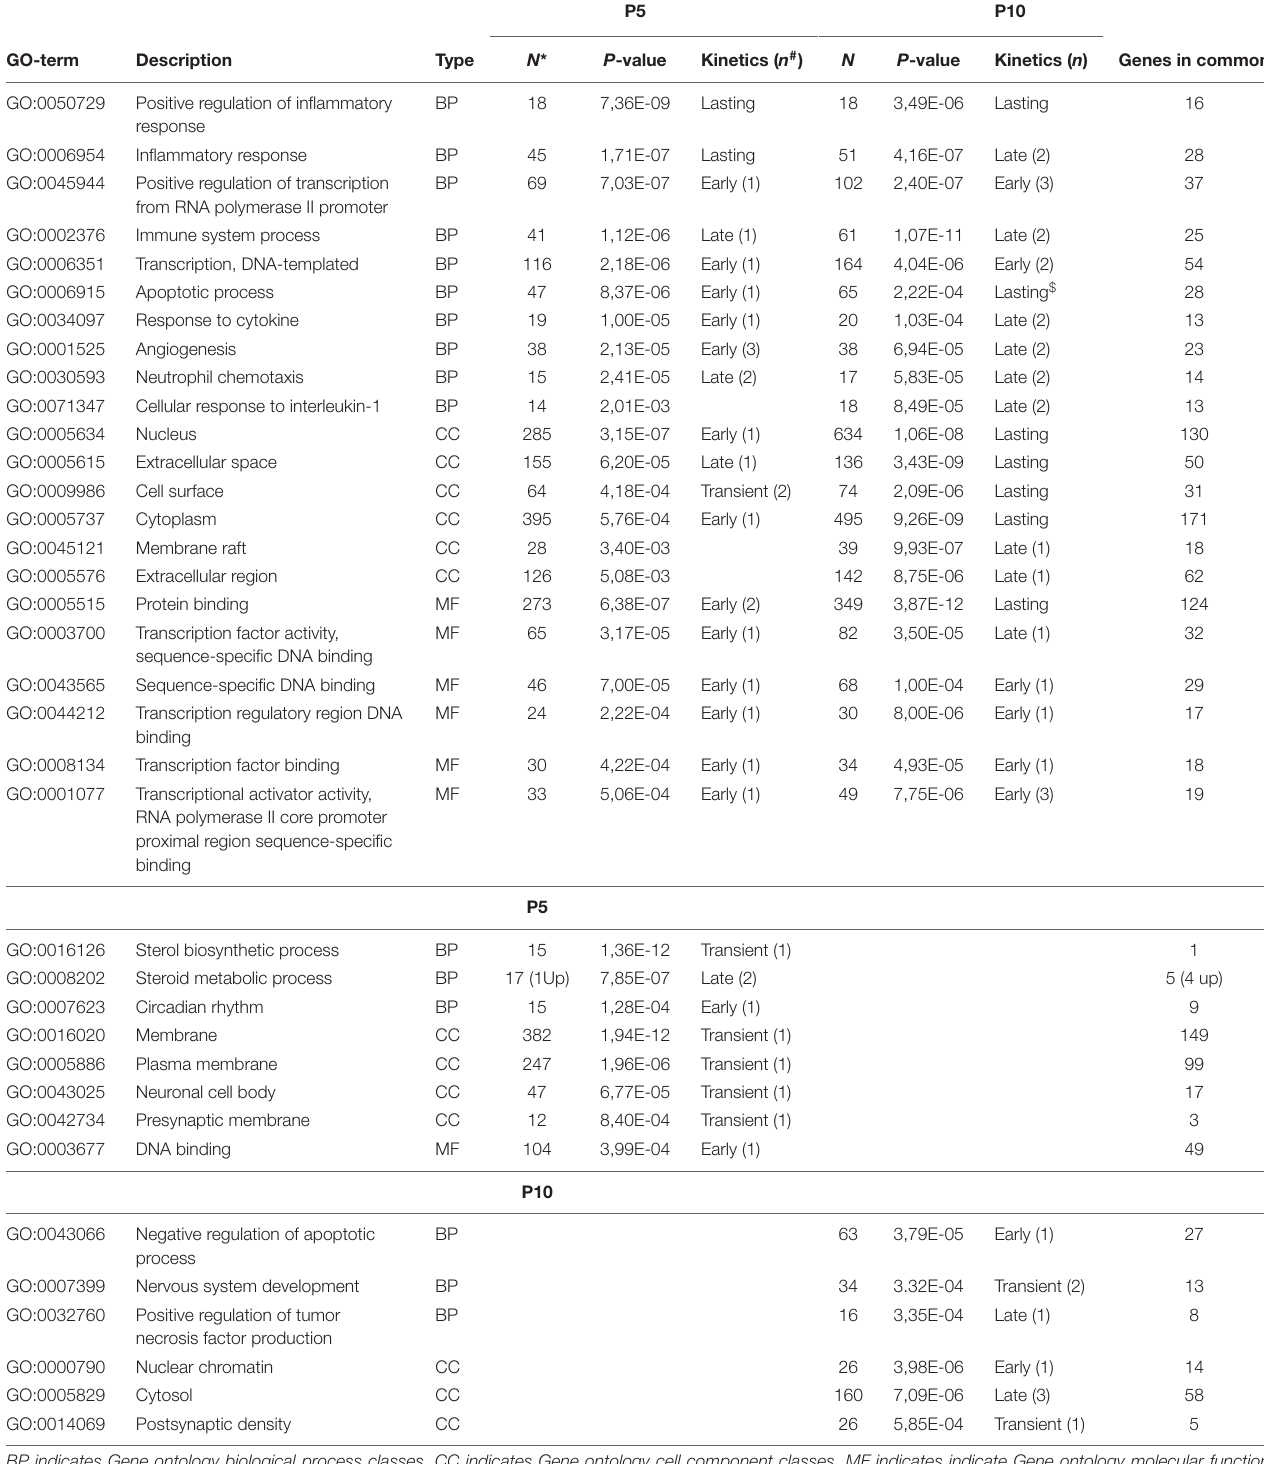
BP indicates Gene ontology biological process classes, CC indicates Gene ontology cell component classes, MF indicates indicate Gene ontology molecular function classes. *N indicates the number of genes associated with GO-term. # n indicates the number of time points of significant determination of GO-term. Lasting determination indicates enrichment at the 4-time points, $ apoptotic process at unique time points in the P10 brain never reached the 1E-3 threshold but reached significance when assessed over the entire